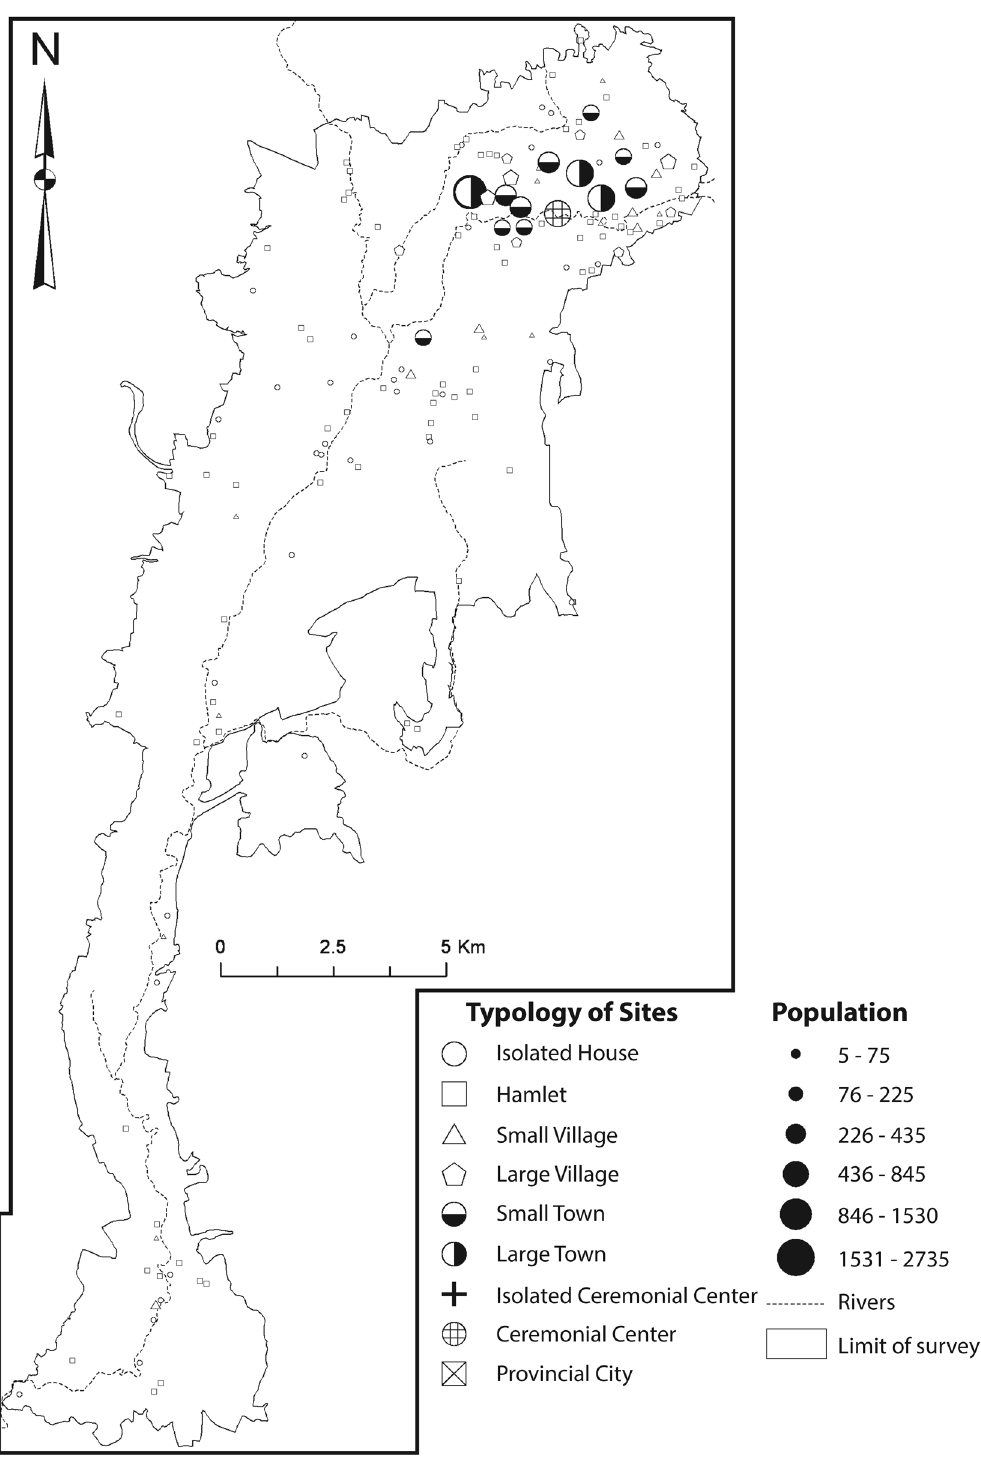
Figure 13: Settlement patterns of the Early Postclassic and Ticoman in the southern half of the valley – moved to new locations within a few kilometers of their former sites ( Figures 15 and 16 ) . This was a time of major interregional exchange, economic expansion, and prosperity among the city - states of Morelos ( Smith, 2004, 2016 ) .